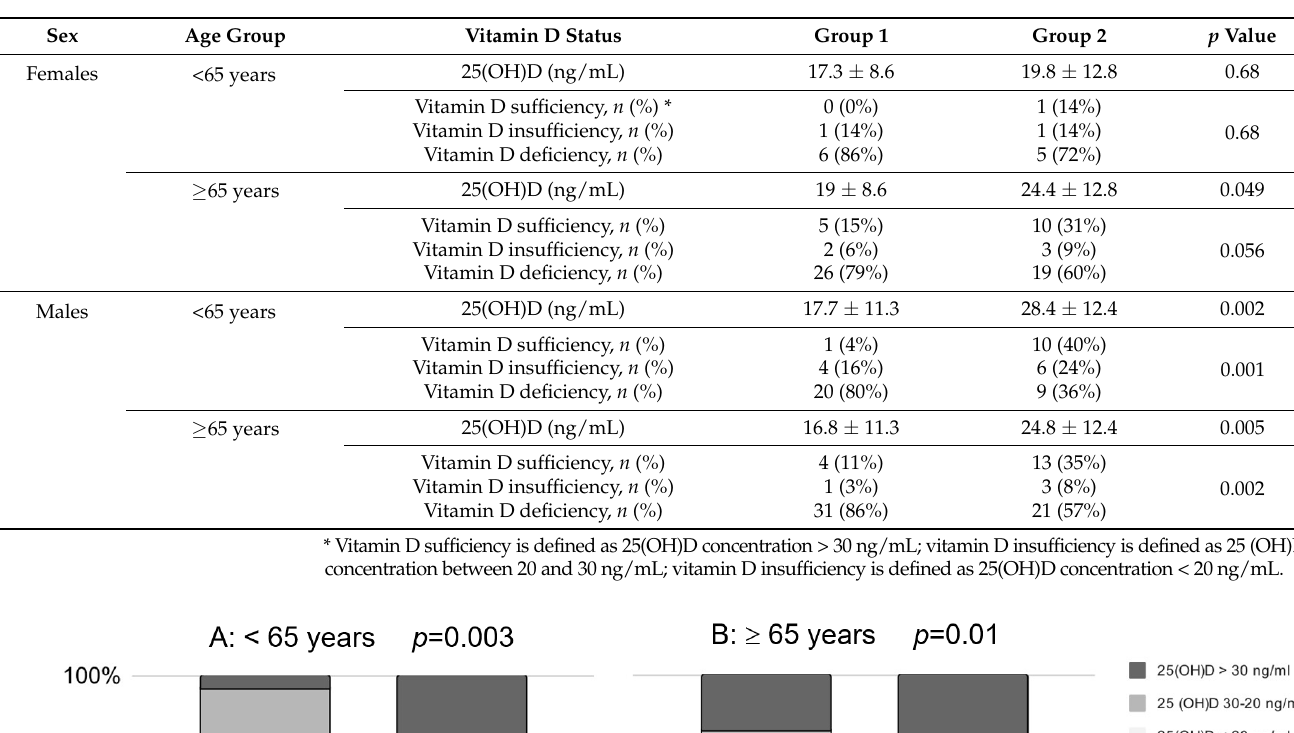
from 79% to 60%, and vitamin D sufficiency increased from 15% to 31%, which was borderline statistically significant ( p = 0.056) (Table 3). Table 3. Comparison of vitamin D status upon admission according to age group in patients admitted to the hospital in the second wave (Group 1), and in the third wave (Group 2) of the COVID-19 pandemic. Data are expressed as numbers and percentages or means ± standard deviations.